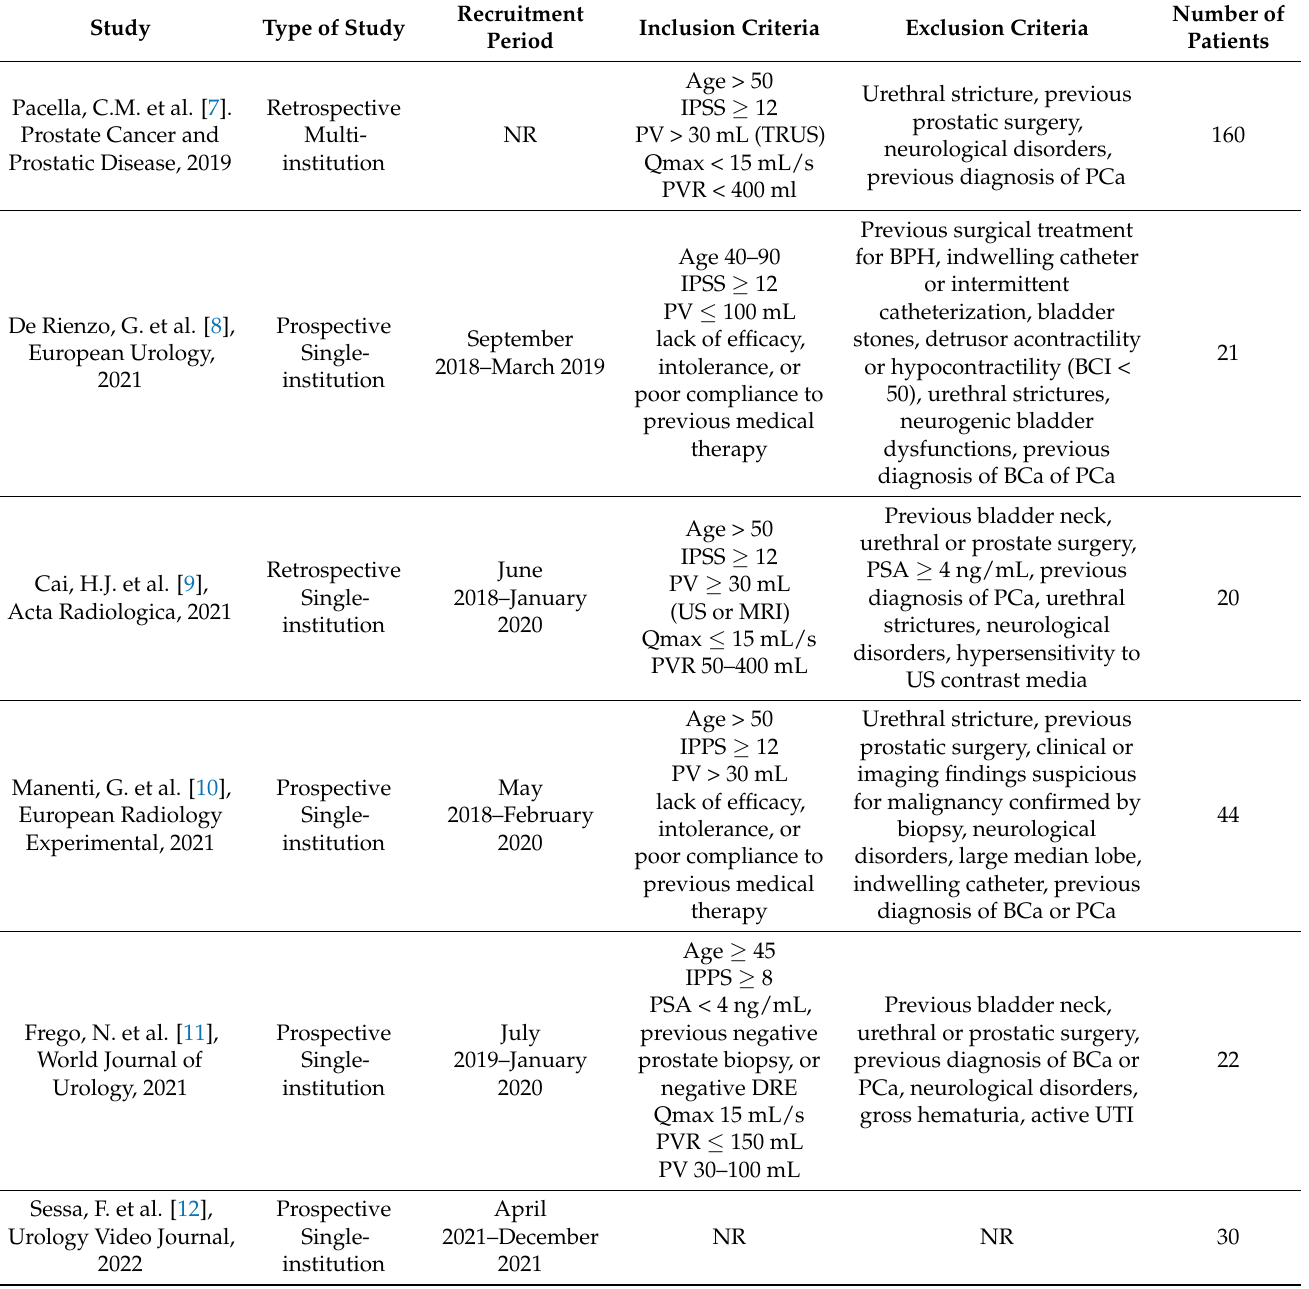
Table 1. Characteristics of the six included studies that evaluated the efficacy of transperineal laser ablation (TPLA) for benign prostatic enlargement